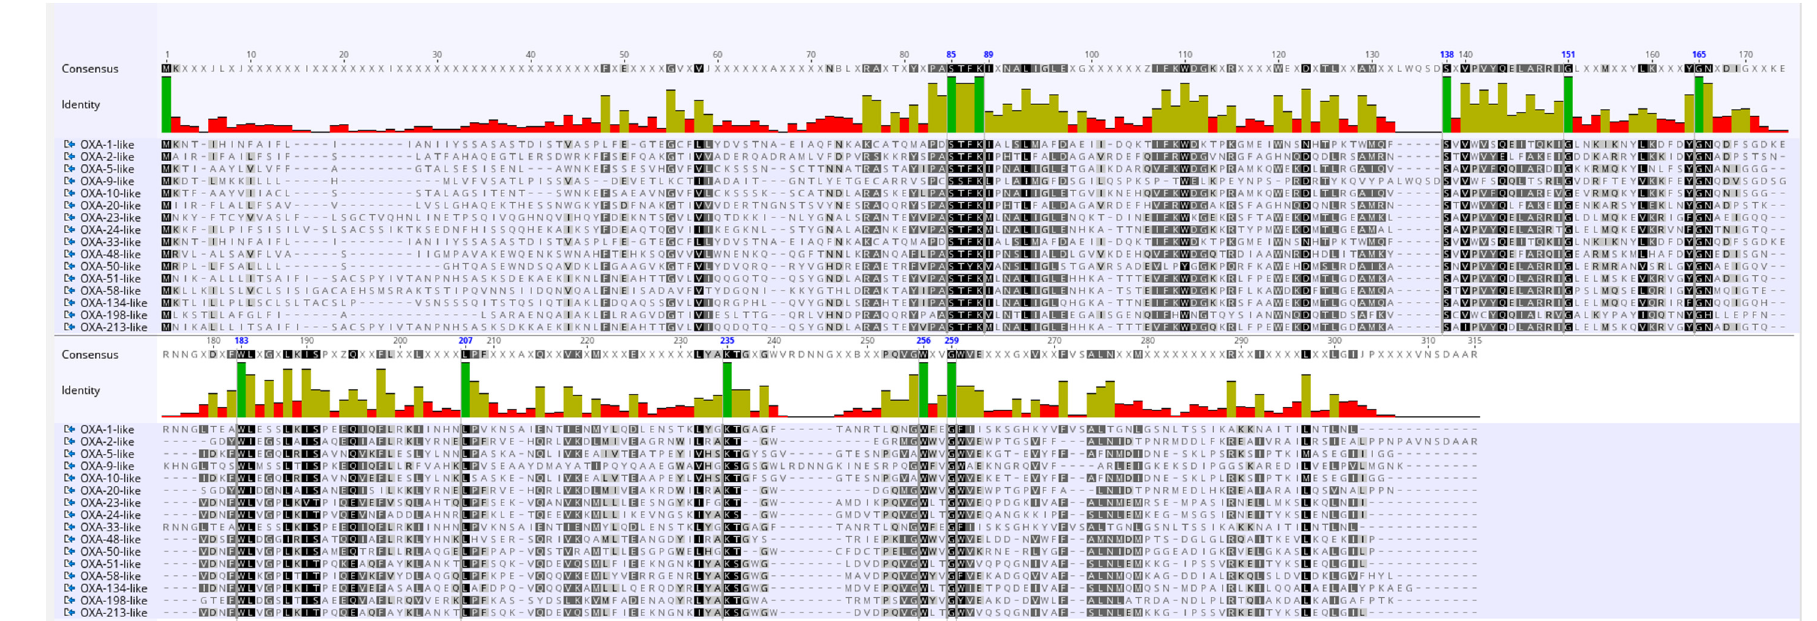
Figure 2. Multiple sequence alignment of a representative sequence from sequences of the 16 OXA subfamilies. In the conservation plot, identical amino acid residues are highlighted in dark green color.